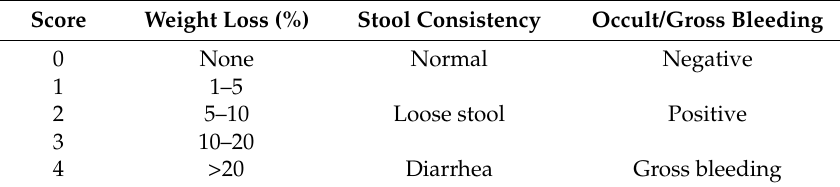
Table 2. Criteria for disease activity